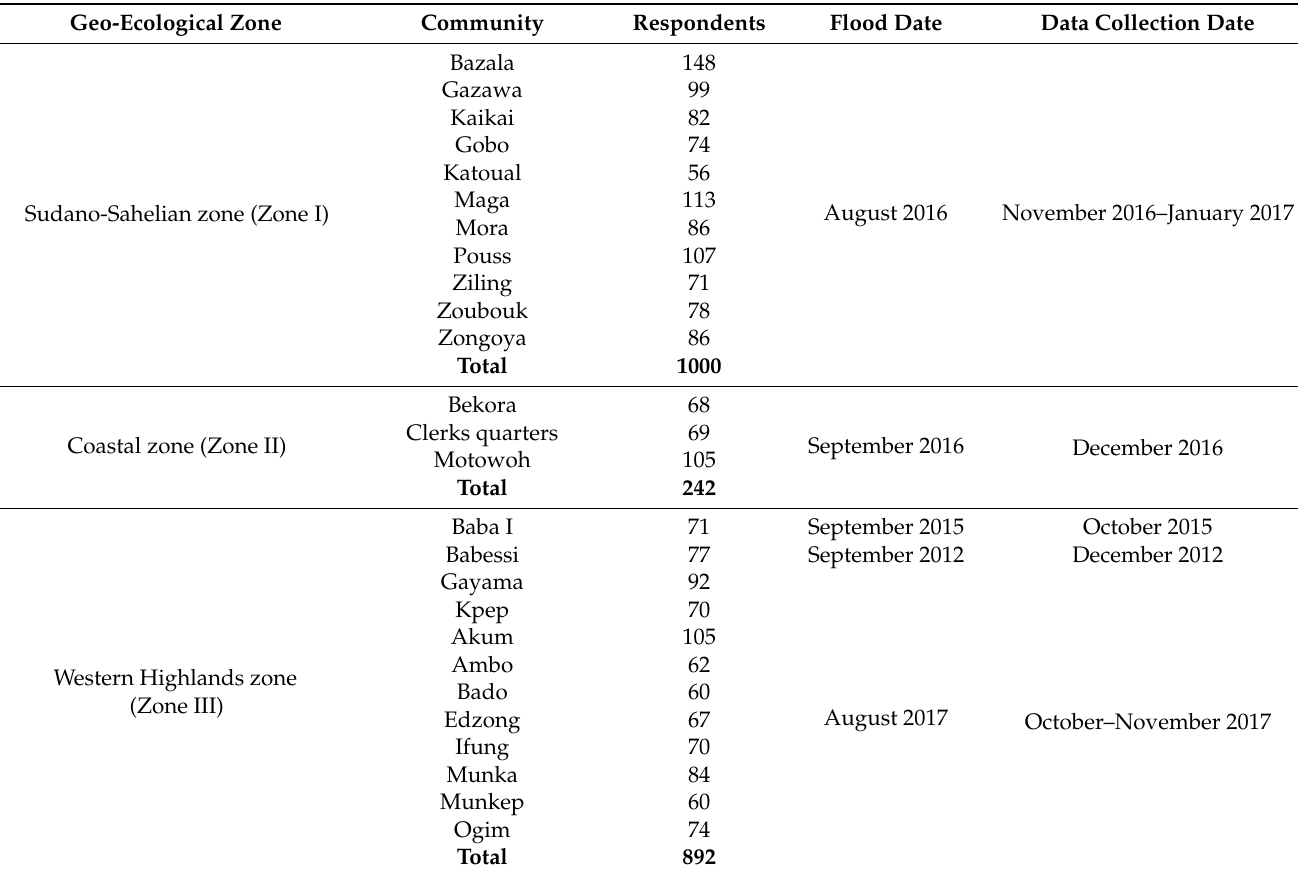
Table A1. Schedule of floods and data collection